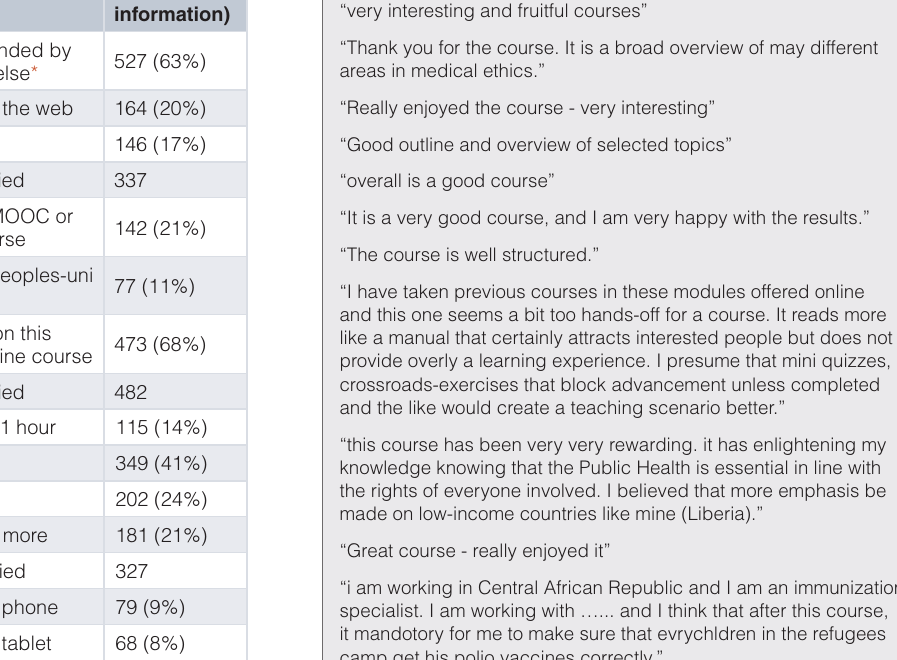
Table 3. Information from 1174 students registered on Peoples-uni Open Online Courses. Question Response